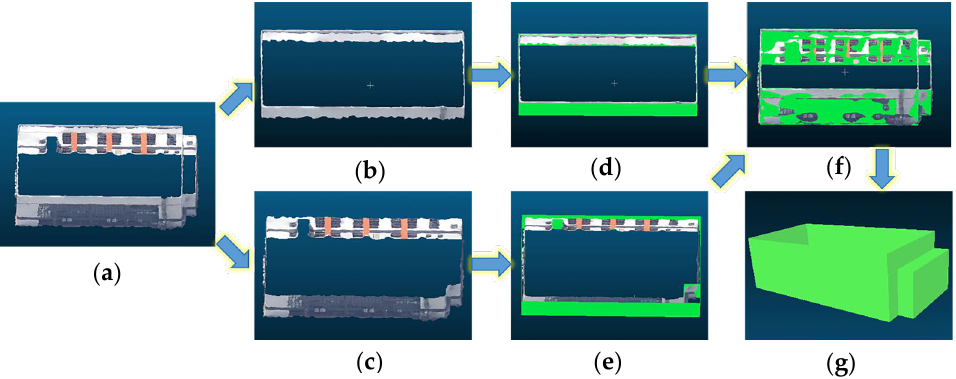
Figure 1. The workflow of the proposed approach: ( a ) input of the photogrammetric mesh model; ( b , c ) segmented components; ( d , e ) minimum circumscribed cuboids; ( f ) adjusting model; ( g ) final 3D building façade model.